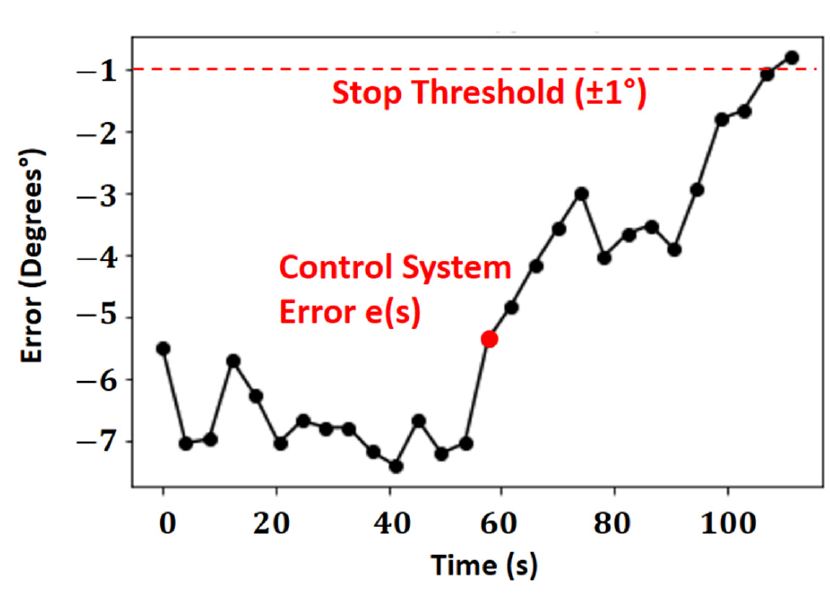
Figure 10. Control system of error in the repositioning operation.